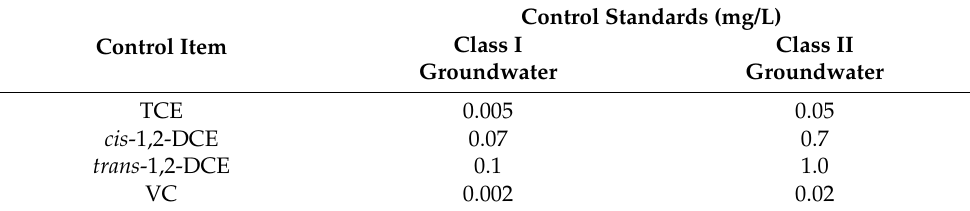
Table 2. Taiwan Groundwater Control